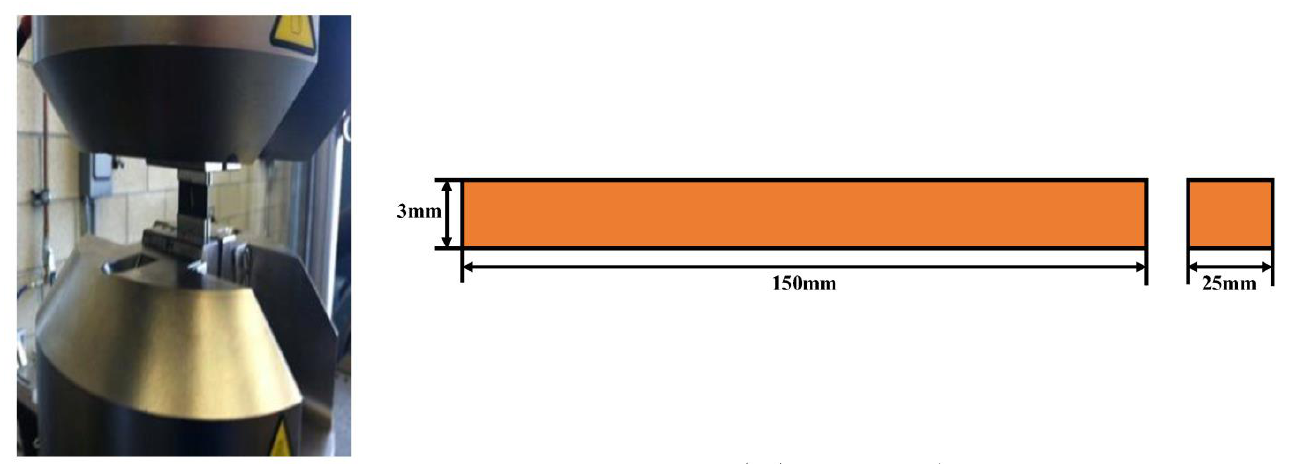
Figure 3. Quasi-static compression test arrangement.